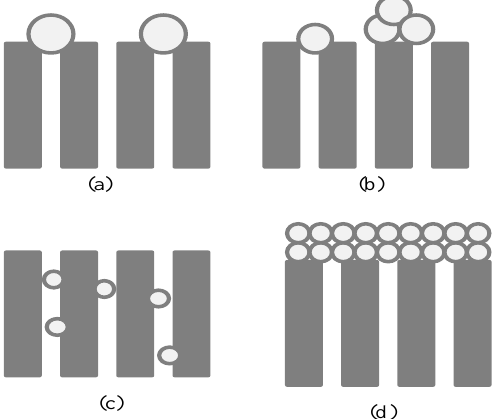
Figure 3. Schematic representation of different pore fouling mechanisms considered by the Hermia’s model: ( a ) complete pore blocking; ( b ) intermediate pore blocking; ( c ) standard pore blocking, and ( d ) cake layer formation.